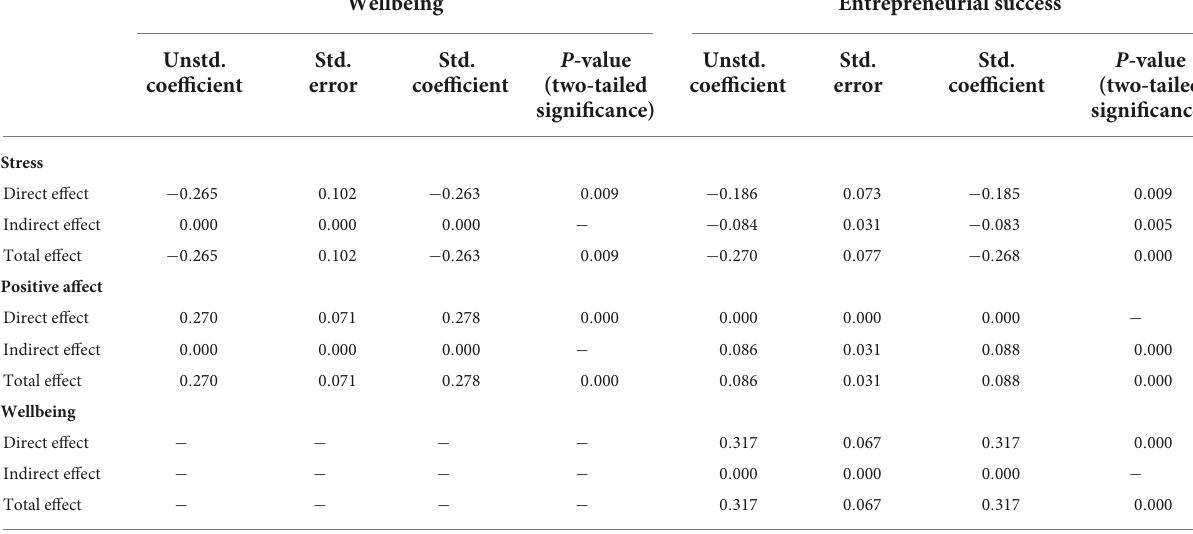
FIGURE2 Results of model testing.